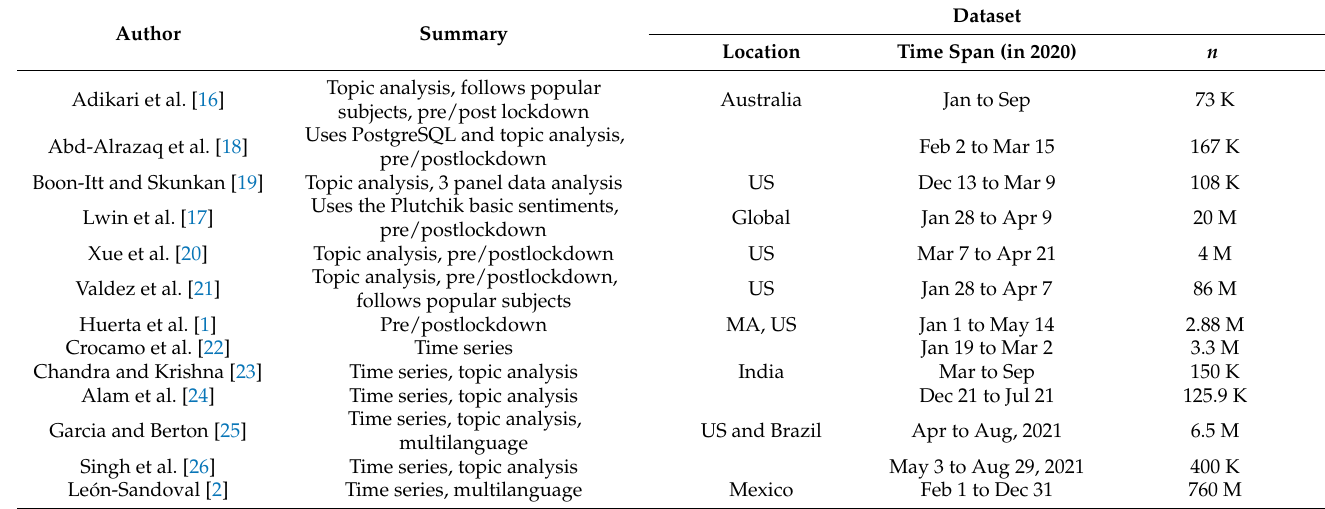
Table 2. Summary of studies evaluating sentiment polarity over COVID-19-related